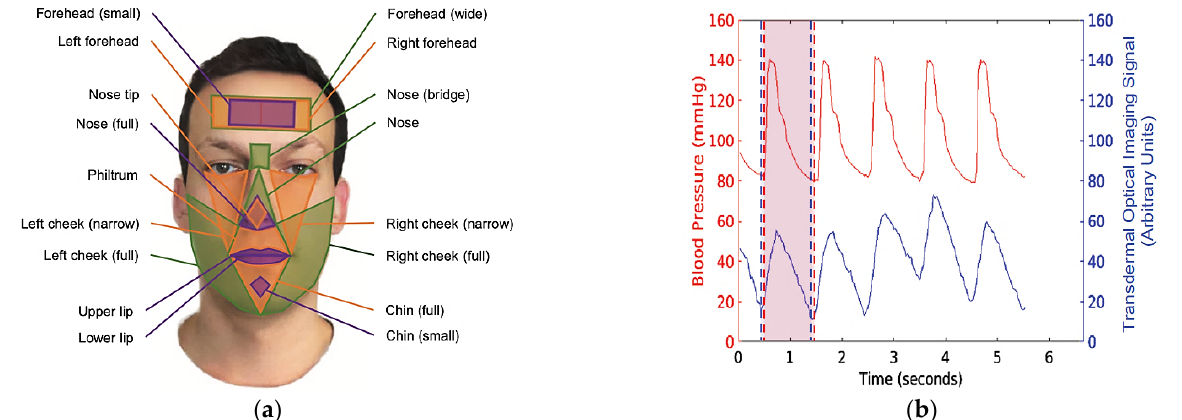
Figure 3. Regions of signal extraction and blood pressure signal; ( a ) demonstration of the seventeen regions of interest (forehead, nose, cheek, chin, lip, and philtrum); ( b ) recorded TOI signals from a person (raw signal from the green channel; presumed hemoglobin signal in the forehead region of interest) and reference blood-pressure signal (CNAP Monitor 500) exhibit temporally consistent oscillations and occur at ≈ 1 per second [29].